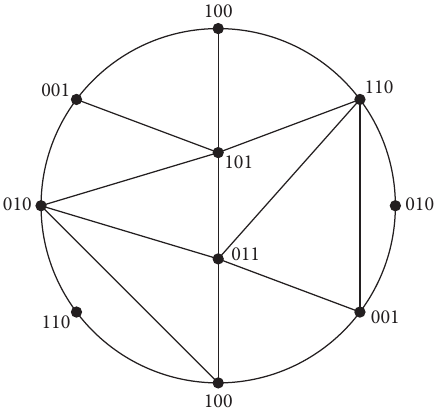
Figure 3: Projective embedding of AG ′ ( Z